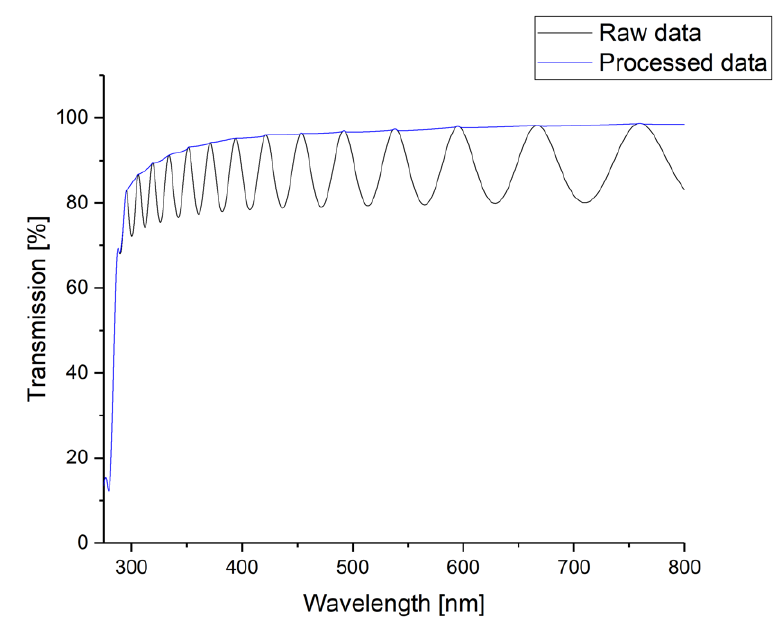
Figure A2. Example for the post-processing of the measured UV-VIS raw data to smooth the spectra: The maxima of the raw data, i.e., the constructive interferences are fitted.